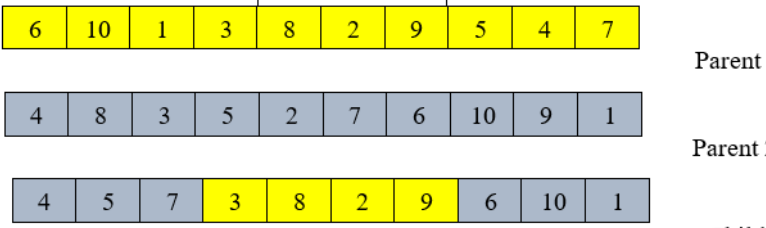
Figure 2. Crossover operator for each part.